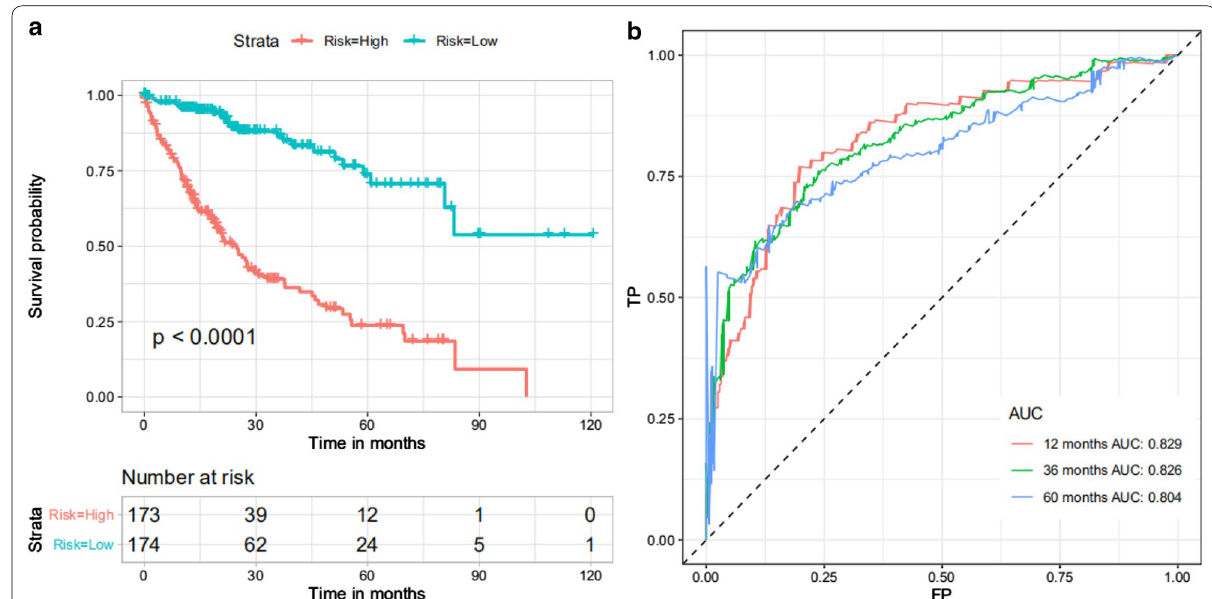
Fig. 7 Exploration of the predictive ability of the prognostic model in the HCC cohort. a Survival analysis of the prognostic model. The upper panel shows the Kaplan–Meier curves for the high- and low-risk groups; the bottom panel shows the number of living patient variations with time in the high- and low-risk groups. Red represents the high-risk group, and blue represents the low-risk group. b ROC curves of predictive models at 1, 3, and 5 years. Red represents 1 year, green represents 3 years, and blue represents 5 years